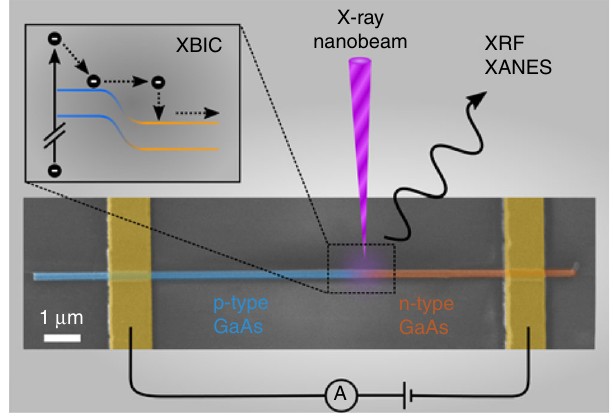
Fig. 1 Scheme of the nanowire X-ray detector device. Colorized scanning electron microscope image schematically depicting the device with the experimental setup. An energy-tunable hard X-ray beam was focused onto the GaAs nanowire with a p – n junction along the growth axis and a diameter of 150 nm. The nanowire was contacted, which allowed for in- operando X-ray beam induced current (XBIC, see inset), X-ray fl uorescence (XRF), and X-ray absorption near-edge spectroscopy (XANES) measurements while applying external